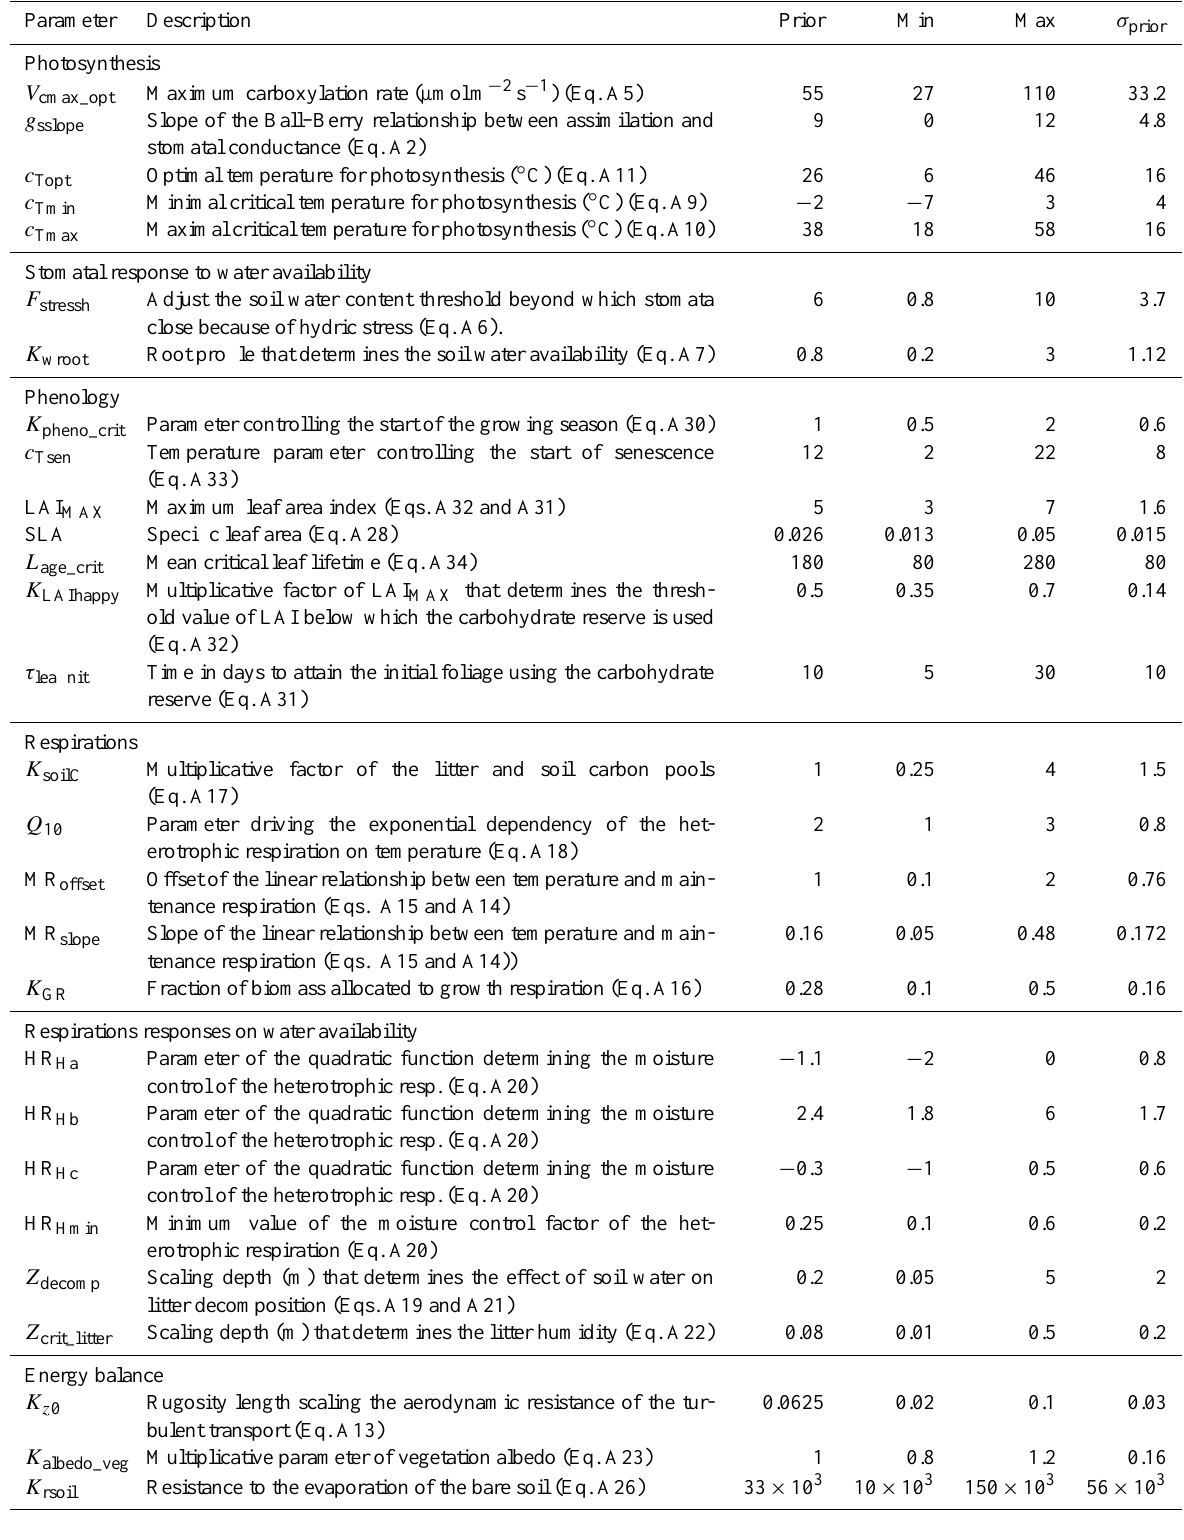
Table 1. Parameter names with their description and corresponding model equations (Appendix A), ranges of variation, a priori values and uncertainties of the